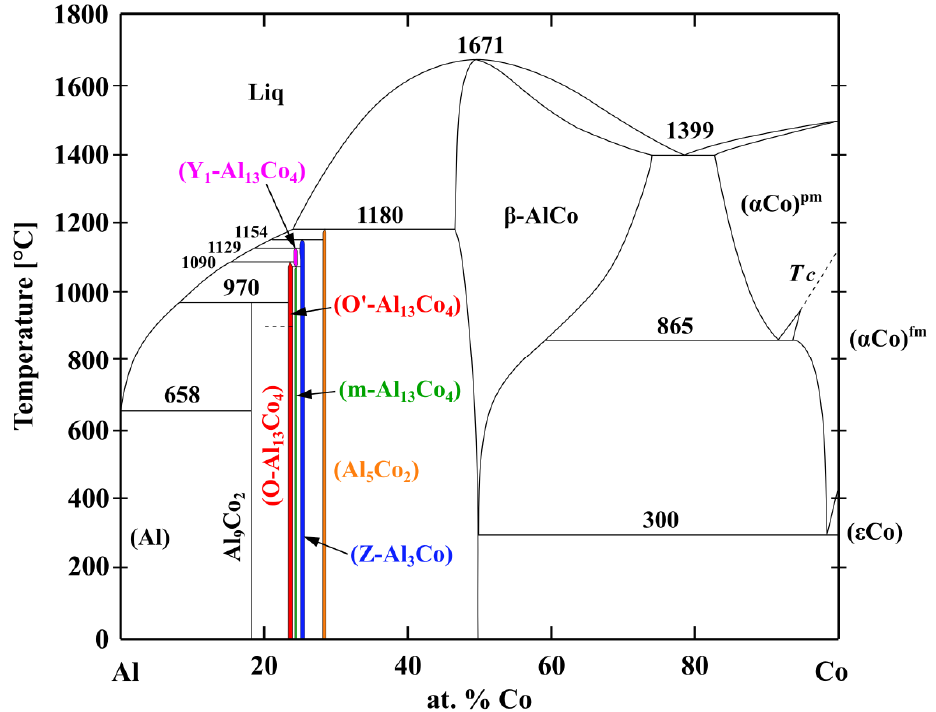
Figure 1. Phase diagram of the Al-Co binary system, redrawn from [23,24].